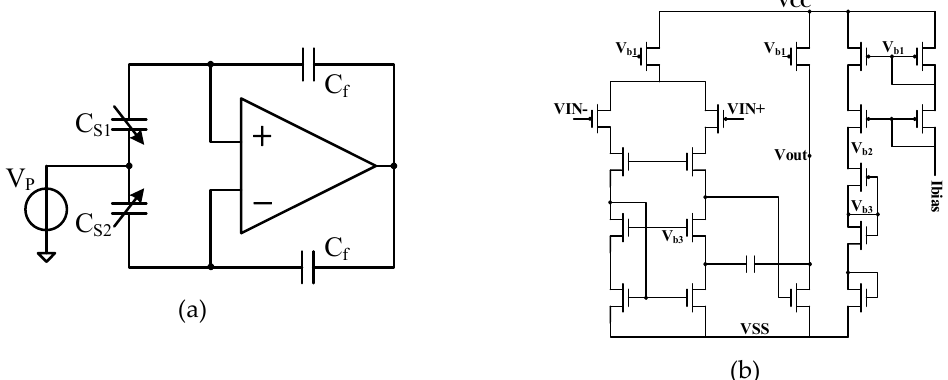
Figure 8. ( a ) Charge amplifier based on high frequency carrier principle, ( b ) topology of nested Miller Compensation second-order operational amplifier.